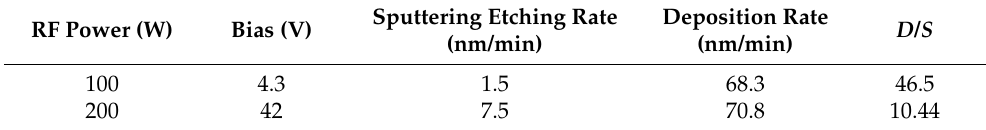
Table 1. Deposition data for various RF